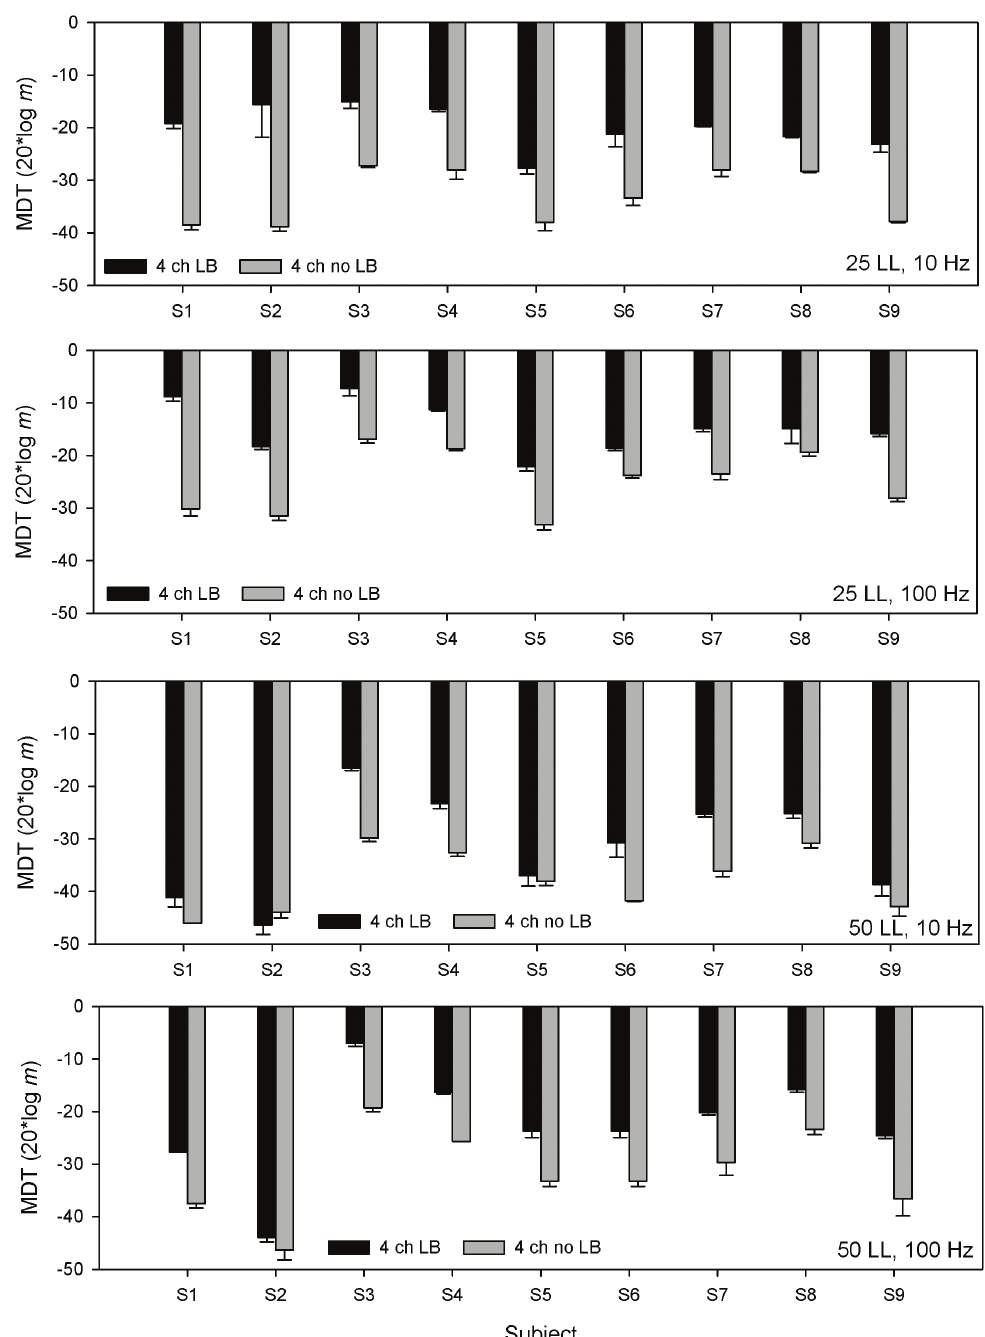
Figure 3. Multichannel MDTs for individual CI subjects. From top to bottom, the panels show 10-Hz MDTs at 25 LL, 100-Hz MDTs at 25 LL, 10- Hz MDTs at 50 LL, 100-Hz MDTs at 50 LL, respectively. The black bars show the MDTs for the 4-channel loudness-balanced stimuli (i.e., equally loud as the single-channel stimuli in Fig. 1) and the gray bars show MDTs for the 4-channel stimuli without loudness-balancing (i.e., louder than the single- channel stimuli in Fig. 1 and the 4-channel loudness-balanced stimuli). The error bars show the standard